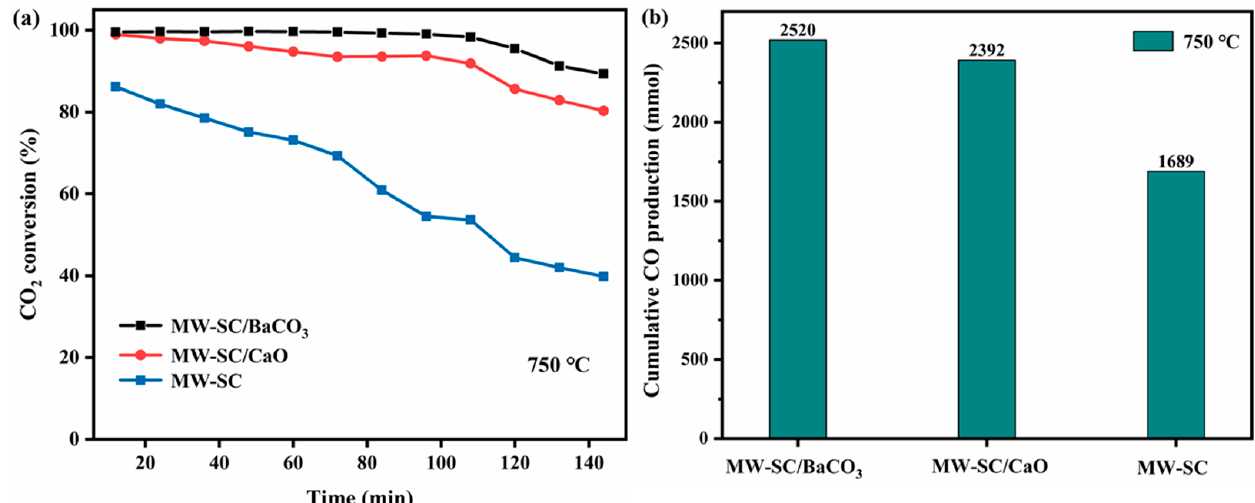
Figure 4. ( a ) Comparison of SC, SC/BaCO 3 and SC/CaO gasification reactivity under a microwave (MW) at 750 ◦ C; ( b ) CO output at different experiment reactions with the reaction times of 144 min.